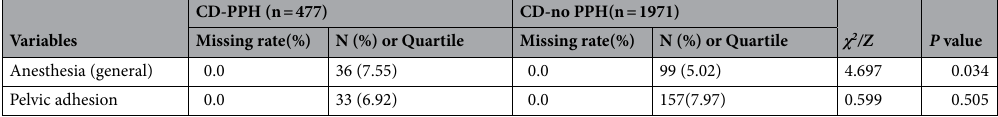
Table 1. Univariate analysis of CD-PPH and CD no-PPH in the training set. N, number of samples; %, percent; Quartile, inter-quartile range between 25th and 75th percentiles; χ 2 , value for chi-square test; Z, value for Mann–Whitney U test.